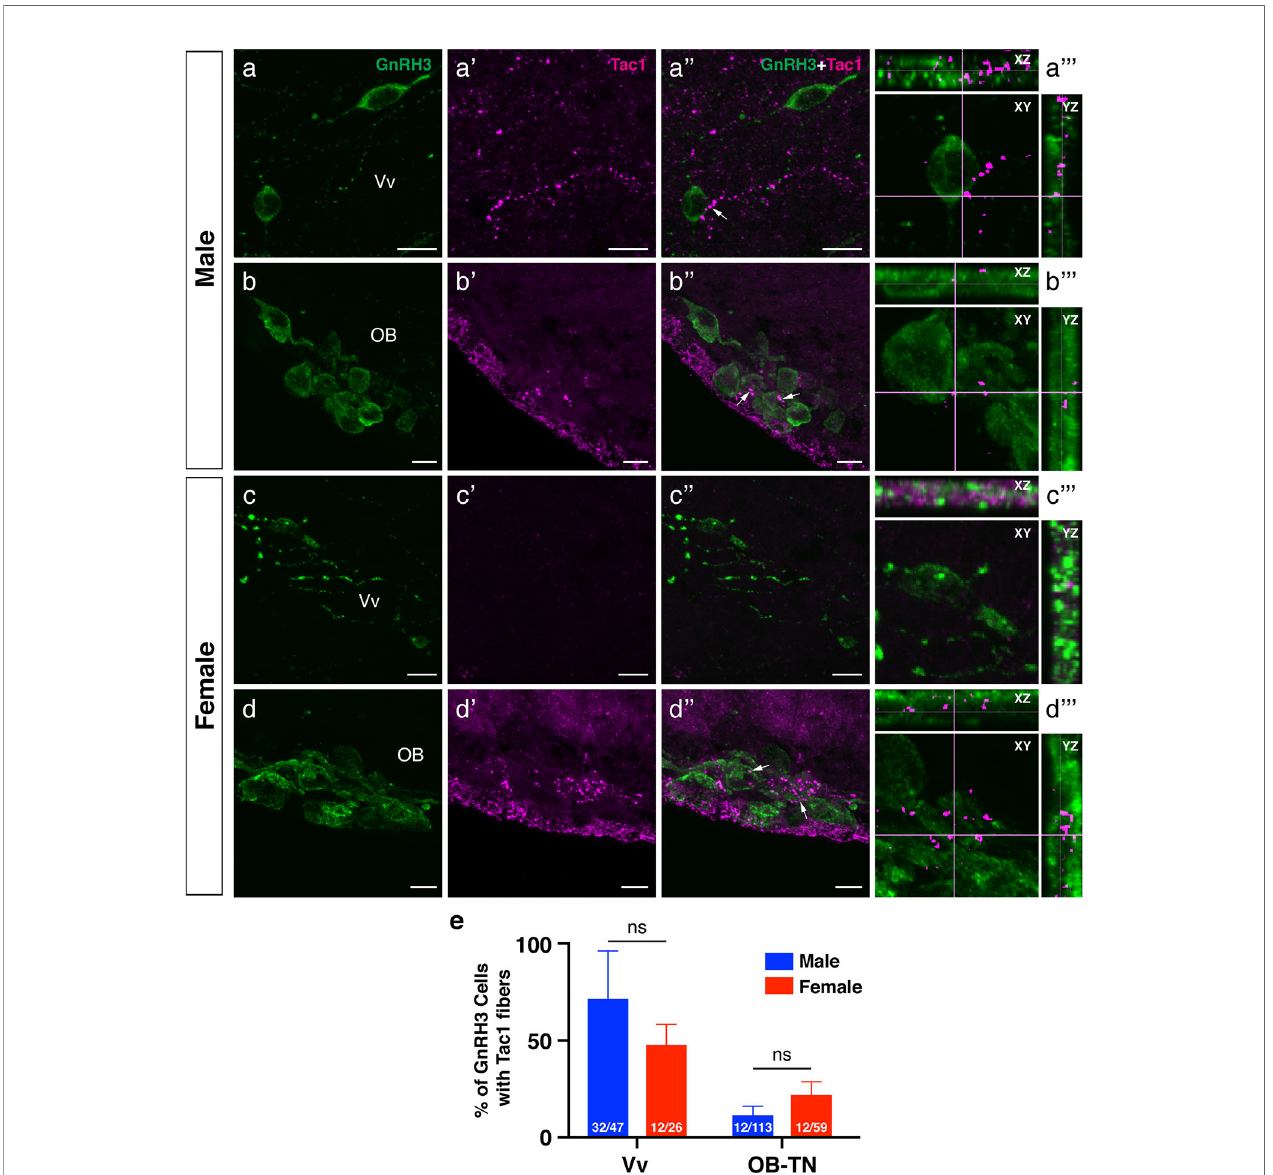
FIGURE 7 | Neuronal association between Tac1-immunoreactive processes and GnRH3 cell soma in the male and female zebra fi sh. Photomicrographs for immuno fl uorescence of GnRH3 (1 st column, A − D ), and Tac1 (2 nd column, A ’ − D ’ ) were merged (3 rd column, A ” − D ” ) to elucidate the possible neuronal association (arrows) between Tac1 and GnRH3 neurons. A representative GnRH3 cell soma accompanied by Tac1 processes was further examined by two-dimensional confocal scanning in XY, XZ, and YZ plane (4 th column, A ’” − D ’” ). Bar graphs in the bottom panel (E) show the percentage of GnRH3 cells accompanied by Tac1 processes in males (blue columns) and females (red columns) in the ventral nucleus of ventral telencephalic area (Vv) and olfactory-terminal nerve (OB-TN) region. Numbers in each columns indicate the number of GnRH3 cells accompanied by Tac1 processes and total GnRH3 numbers counted. In the Vv, more Tac1- immunoreactive processes ( magenta ) are in proximities of GnRH3 cells ( green ) in males (A − A ’” ) as compared to females (C − C ’” ) , but there was no signi fi cant difference in the percentage of GnRH3 cells between males and females (E) . In the olfactory bulb (OB), OB-GnRH3 neurons are accompanied by Tac1 processes in both males (B − B ’” ) and females (D − D ’” ) , and there was no signi fi cant sex difference in the percentage of GnRH3 cells (E) . ns, non-signi fi cant. Scale bars: 10